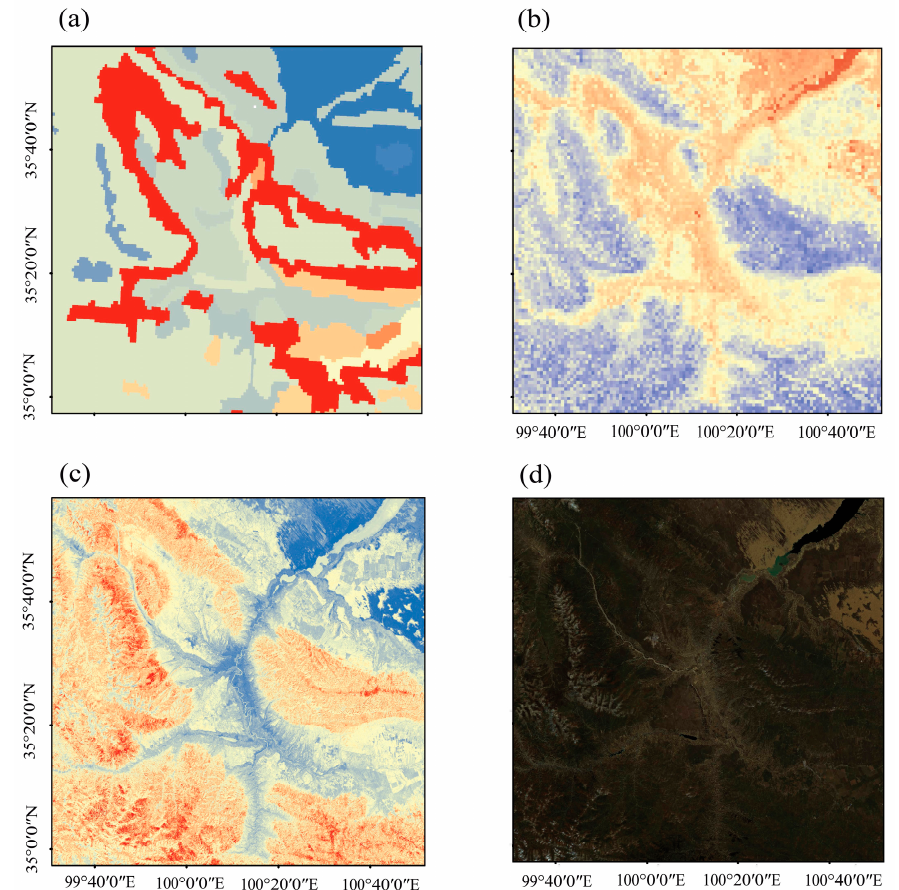
Figure 8. Comparisons of ( a ) HWSD, ( b ) Li’s prediction, ( c ) Our prediction, and ( d ) true color image.